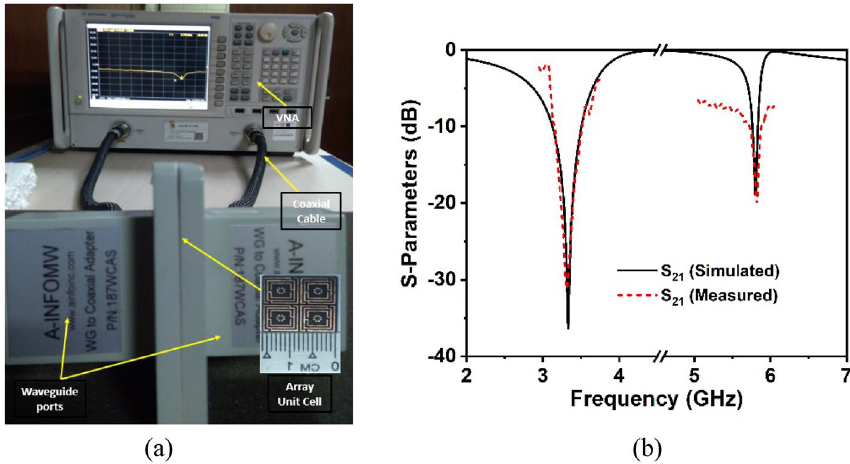
Figure 16. ( a ) Experimental arrangement with assembly parts and ( b ) comparison of measured and CST simulated S 21 responses for a developed 2 × 2 array structure.